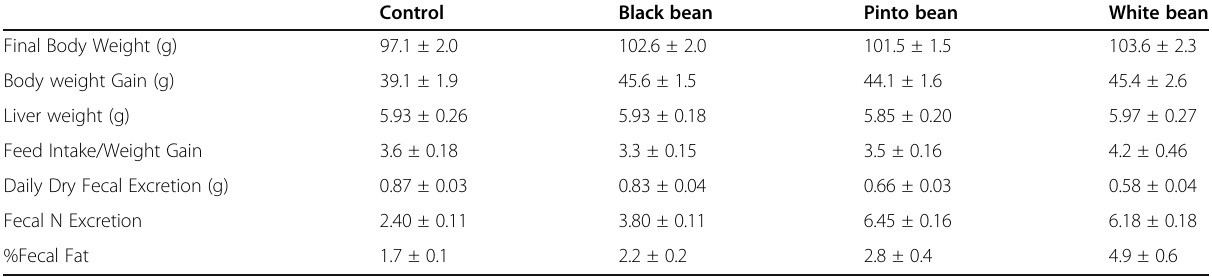
Table 2 Body and organ weights, feed intake and fecal lipid excretion of Hamsters fed extruded black, Pinto and White beans for